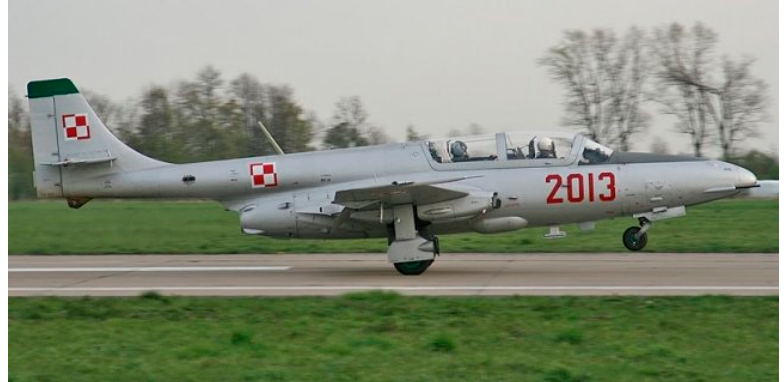
Figure 1. TS-11 “ISKRA”.